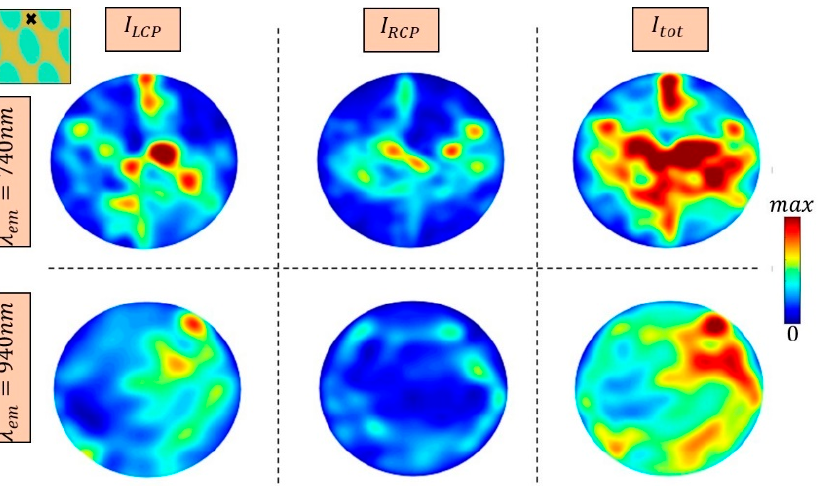
Figure 3. Simulation results for a randomly oriented dipole positioned at Δ x = 0, Δ y = a/2, and Δ z = 120 nm, emitting at 740 nm (top), and 940 nm (bottom); we performed three simulation runs for each dipole orientation, extract LCP, RCP and total far-field intensity for each simulation, and then took the average.